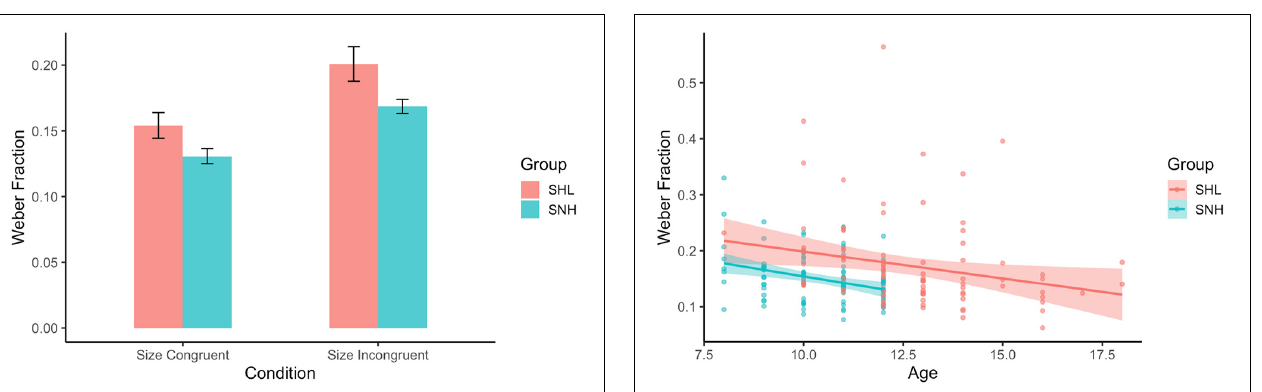
FIGURE 5 | Weber fraction by age and group membership. In both groups, increasing age was linked with decreasing Weber fractions. Line corresponds to best-fitting linear relationship between Age and Weber fraction for each group. Shading corresponds to 95% CI.